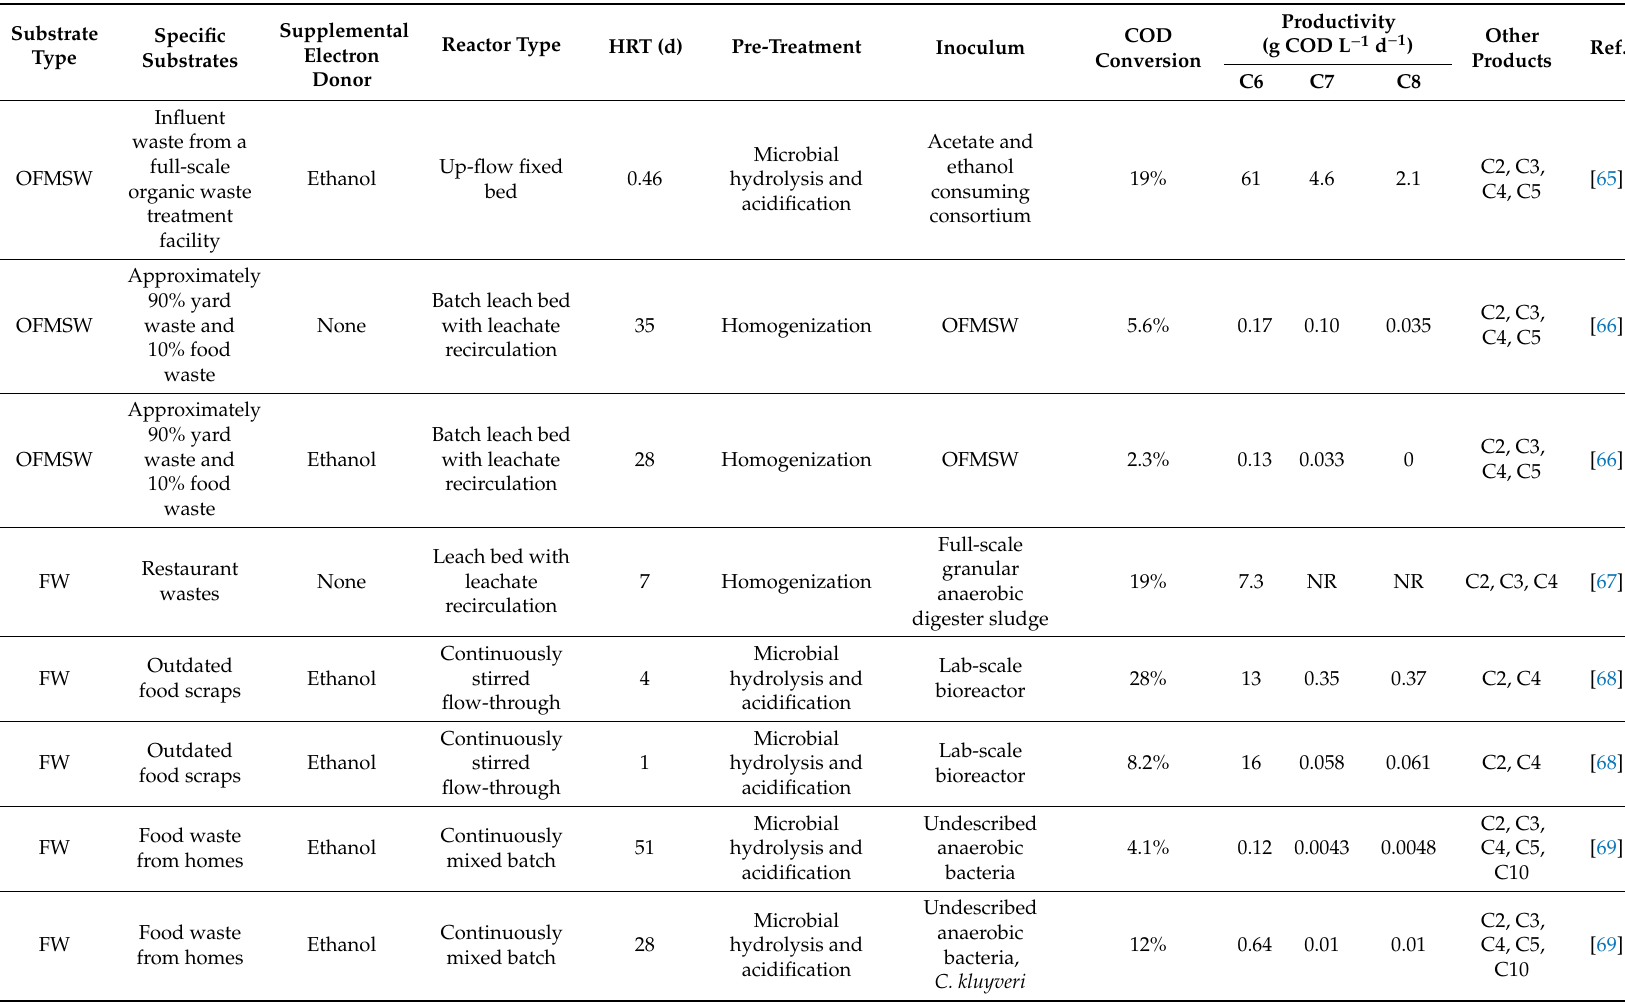
Table 3. A summary of studies investigating MCFA production from high-strength organic